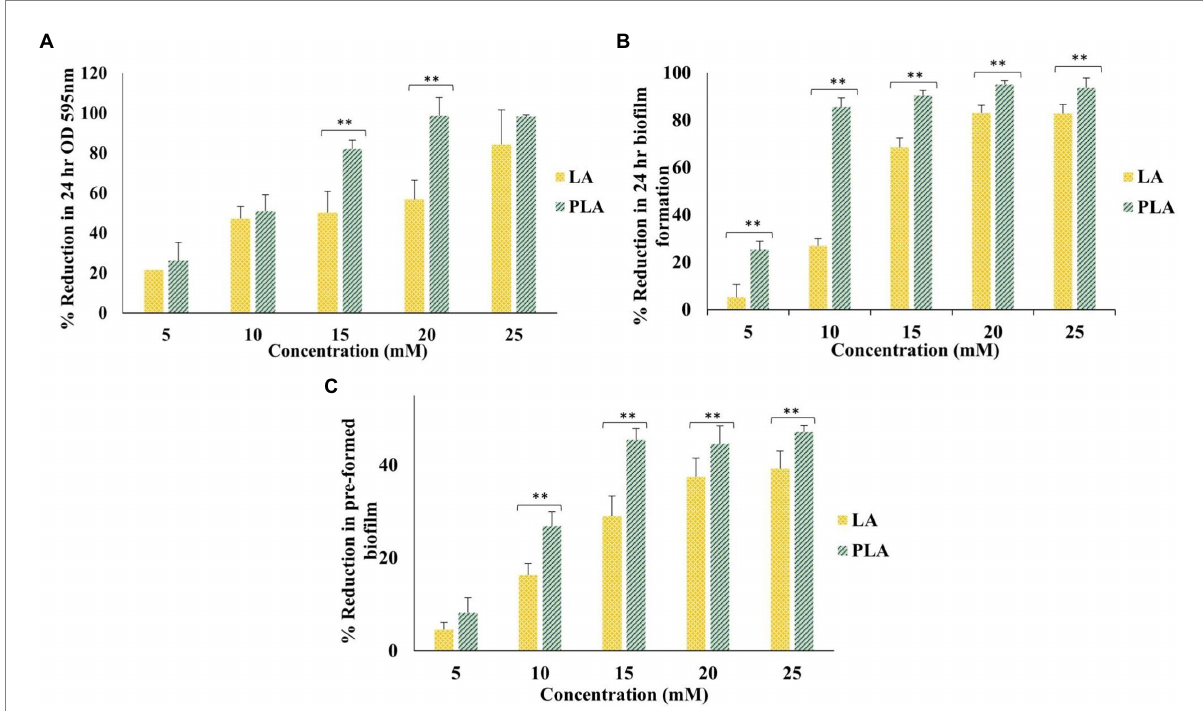
FIGURE 1 Effects of LA and PLA against Aggregatibacter actinomycetemcomitans : (A) 24 h growth as measured by OD at 595 nm, (B) 24 h biofilm formation, and (C) 24 h preformed biofilm, expressed in terms of percentage (%) reduction as compared to the control (BHI/YE media without test sample). The concentrations of LA and PLA were 5 mM, 10 mM, 15 mM, 20 mM, and 25 mM. Data represent the mean value from three independent assays in triplicate, and error bars represent the standard deviation (SD). Differences between groups were determined via one-way ANOVA. ** p < 0.05 between the groups represented in the